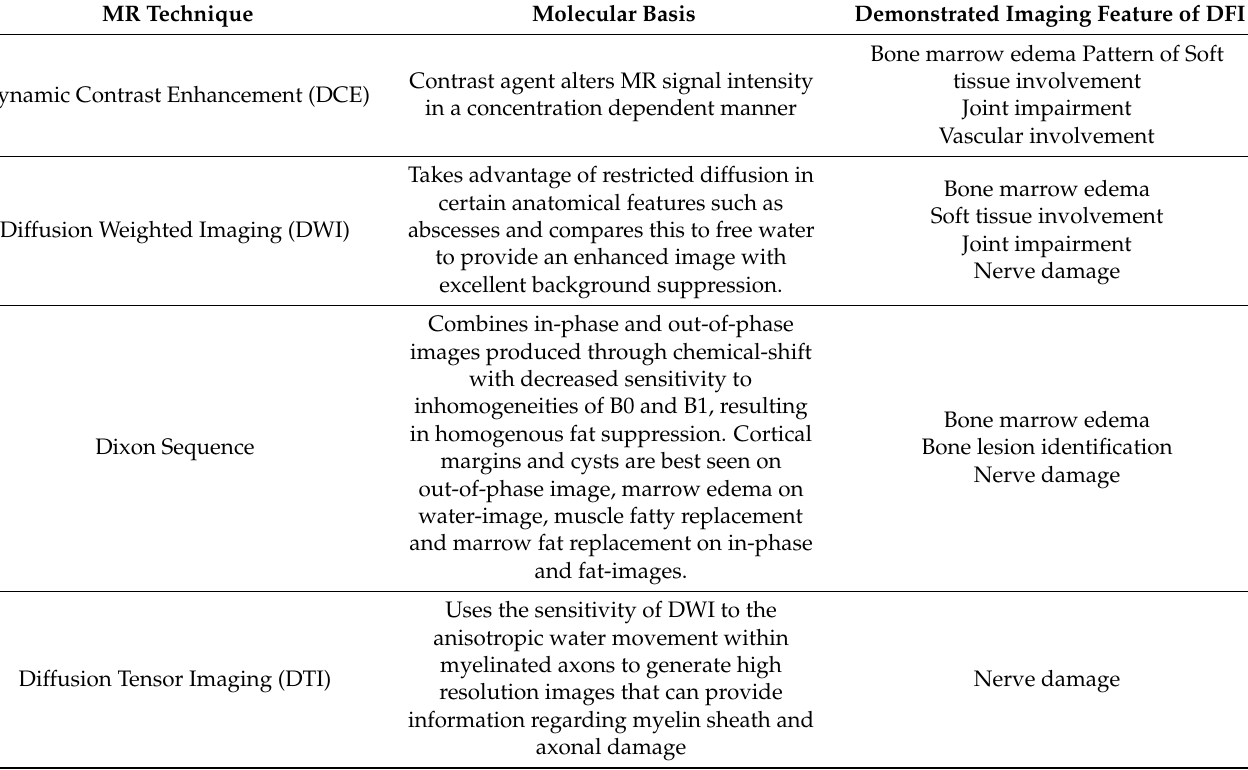
Table 2. Summary of Molecular MR Imaging Techniques in the Assessment of the Diabetic Foot. MR